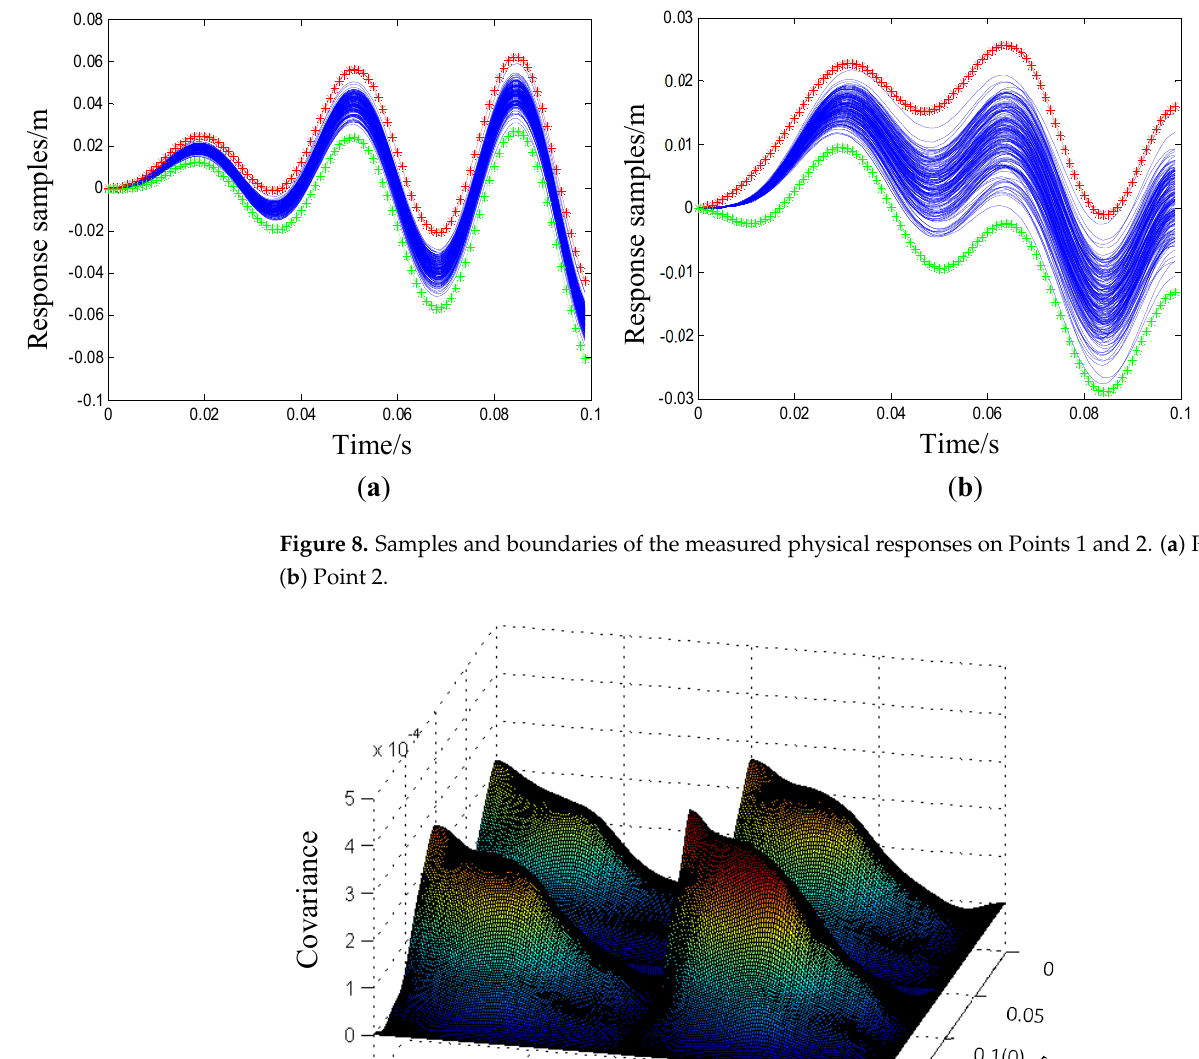
16 of 22 Figure 6. Equivalent sparse identification of the load median function. ( a ) Load time history. ( b ) Load spatial distribution. Figure 7. Validity verification of the identified load median function by response comparison. Next, the covariance matrix of the sparsely identified concentrated dynamic loads is